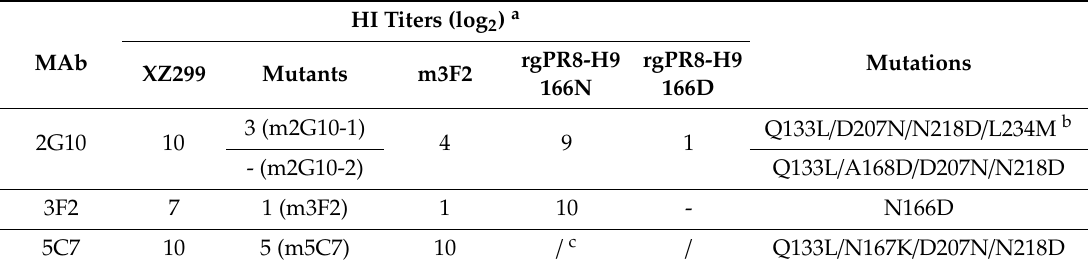
Table 1. Amino acid mutations in the hemagglutinin (HA) of escape mutants derived from A / chicken / Jiangsu / XZ299 / 2016 / H9N2 (XZ299).